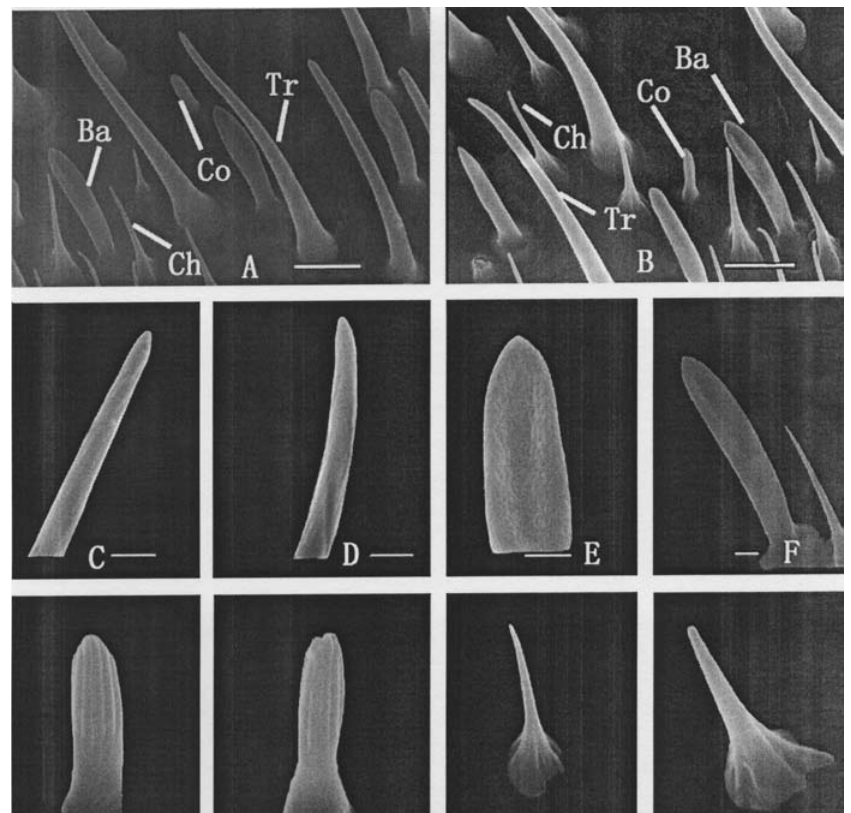
Fig.3 SEM micrographs of antennal sensilla of female decapitating phorid fly P. obtusus (A and B) antennal sensilla on flagellum: (Ba) sensilla basiconica, (Ch) sensilla chaetica, (Co) sensilla coeloconica, (Tr) sensilla trichodea; (C and D) sensilla trichodea; (E and F) sensilla basiconica; (G and H) sensilla coeloconica; (I and J) sensilla chaetica. Scale bars: (A and B) 5μm; (C, D, E, F, G, H, I, and J)